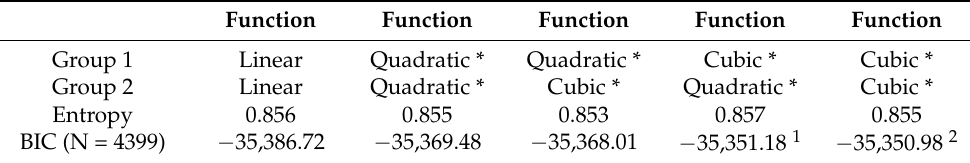
Table 1. Model search process for two-group psychological distress trajectories. Function Function Function